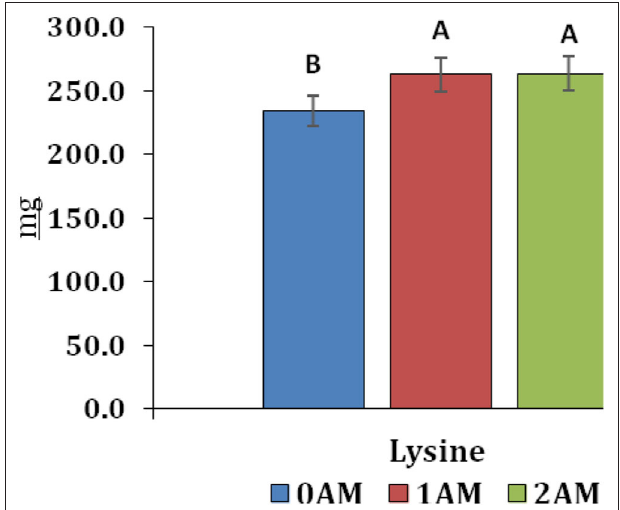
FIGURE 4 | Lysine content of cow’s milk at the end of lactation. 0AM group: received the normal basal ration (Control group); 1AM group: received normal basal ration replacing sunflower cake with 1kg of protein concentrate Agro-Matic until the end of lactation period; 2AM group: received normal basal ration replacing sunflower cake with 1.5kg of protein concentrate Agro-Matic until the end of the lactation period. Different letters revealed a significant difference ( P < 0.05).